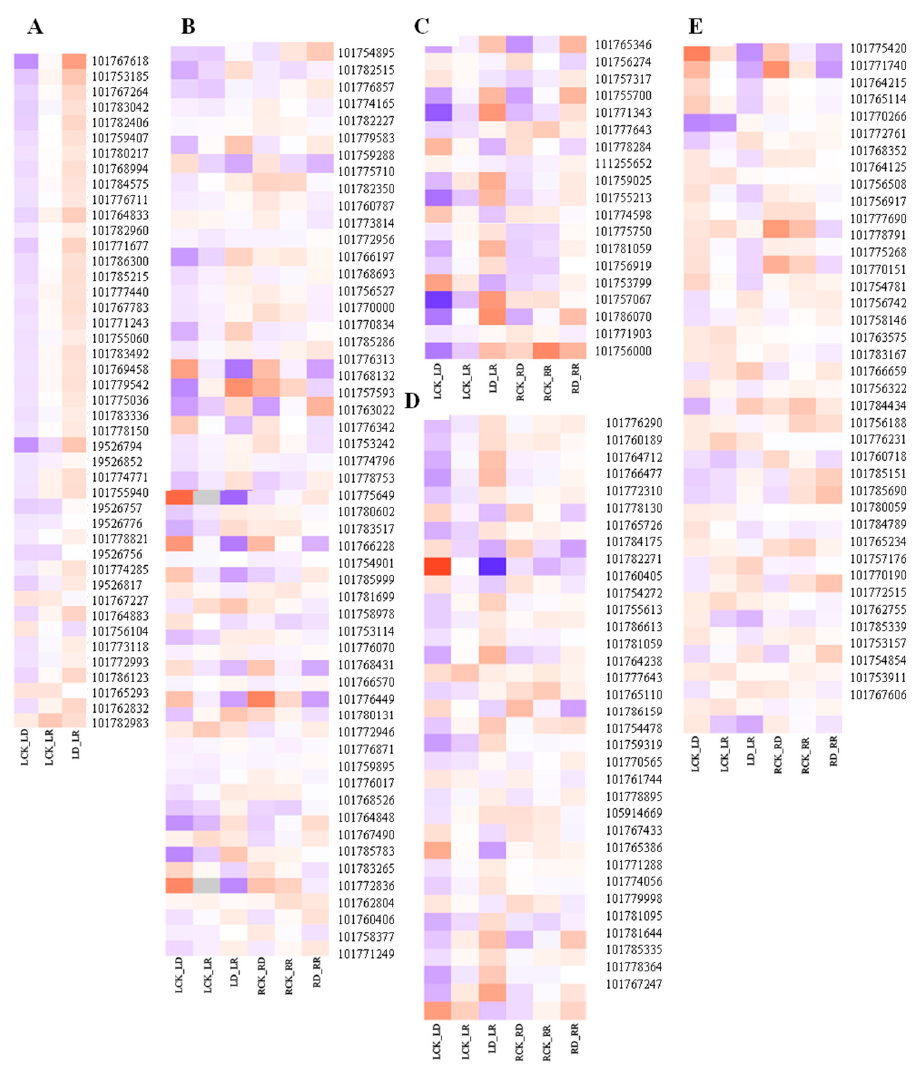
Figure7. Heatmapofprimarydrought-relatedgenes. ( A )Photosynthesis-relatedgenes. ( B )Signaltransduction-related genes. ( C ) Phenylpropanoid biosynthesis-related genes. ( D ) Starch metabolism-related genes. ( E ) Amino acid synthesis-related genes. The X -axis represents gene ID, according to the NCBI database. The Y -axis represents di ff erent comparisons. Relative levels of genes expression are showed by a heatmap with color from blue to red representing the expression levels from low to high. The bar on the right side of the heatmap represents relative expression level of